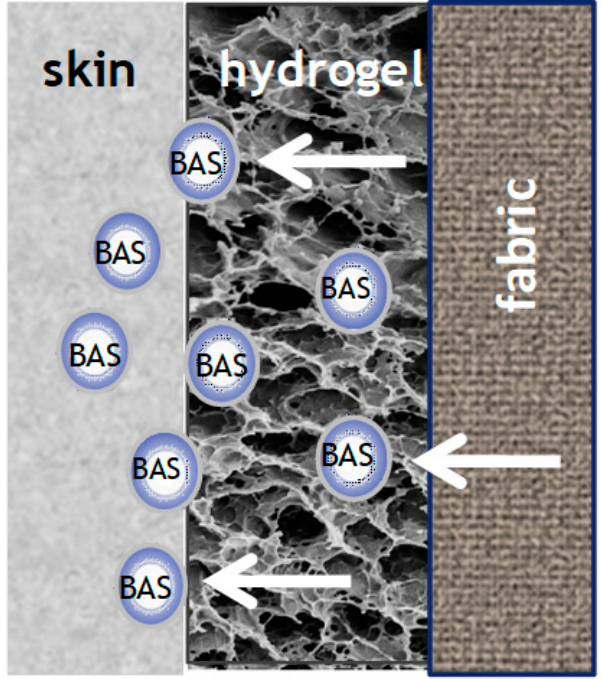
Figure 4. Release of BAS from a hydrogel immobilized onto a modified textile.